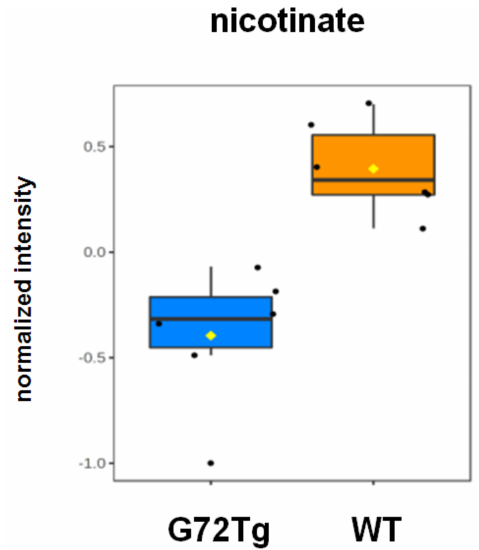
Figure 3. Decreased nicotinate levels in G72Tg compared to WT hippocampi. FDR: 0.015, p = 0.000184 q = 0.0206. Data are presented as box and whisker plots ( n = 6 per group). 3.3. Convergent Protein Expression Changes in Hippocampus and Cerebellum in G72Tg Mice